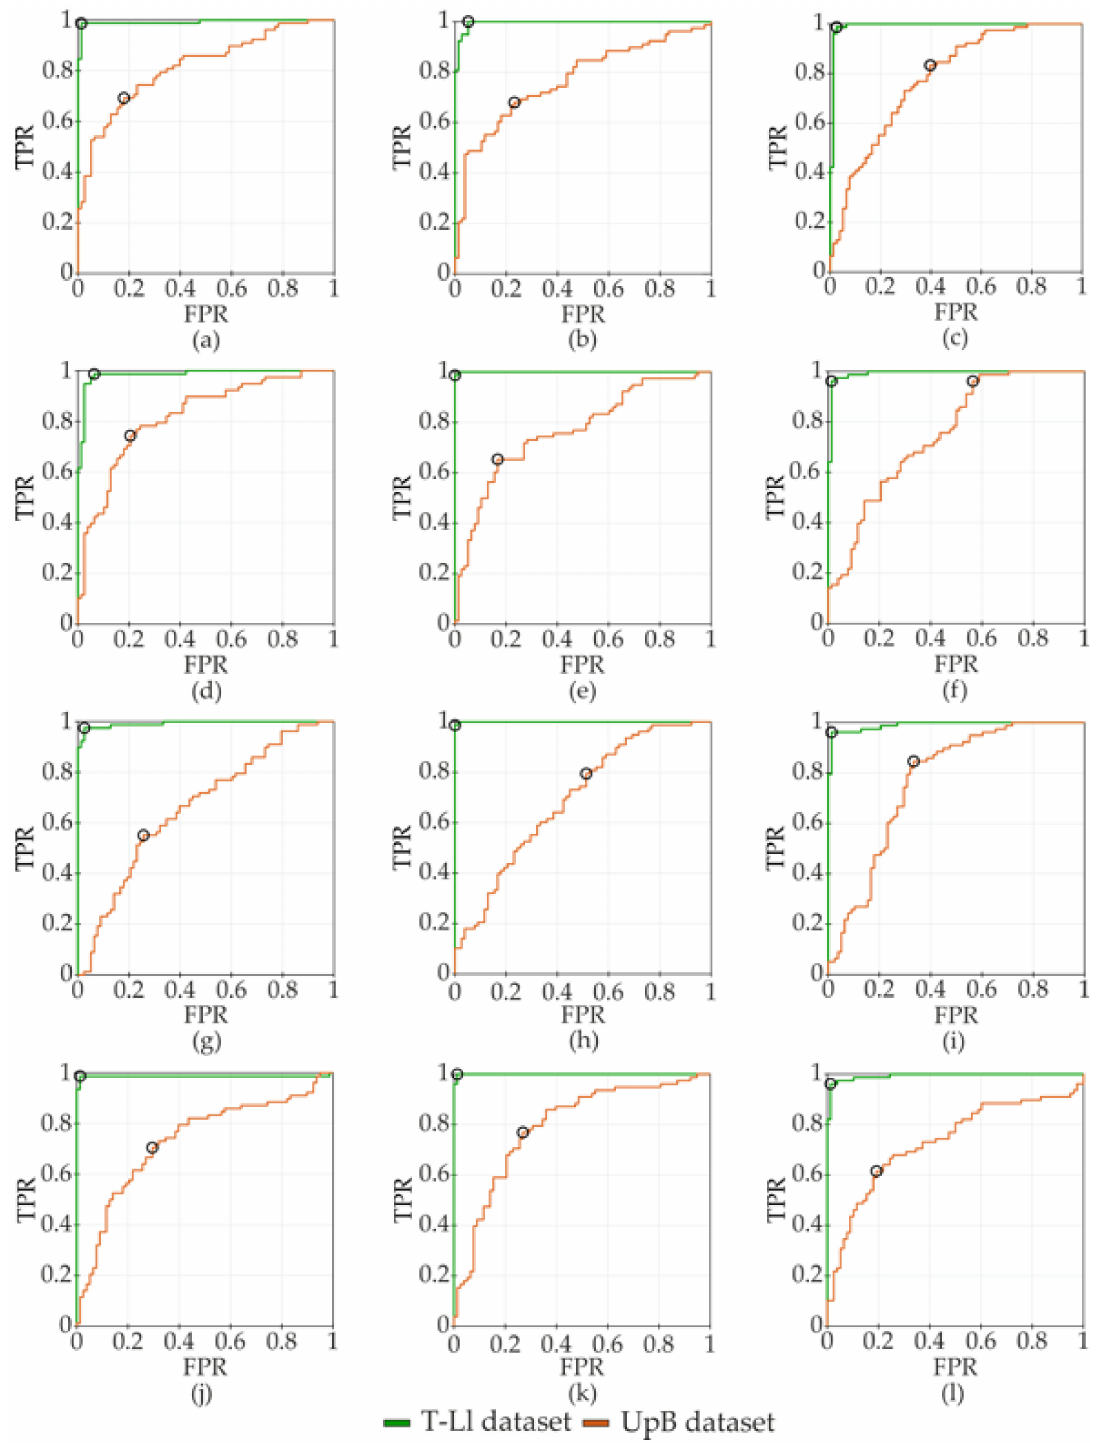
Figure 5. Receiver operating characteristic (ROC) curves of the TL-l dataset and the UpB dataset of the LL task with: linear kernel 1 kg ( a ), 2kg ( b ), and 5 kg ( c ) loads; quadratic kernel 1 kg ( d ), 2 kg ( e ), and 5 kg ( f ) loads; cubic kernel 1 kg ( g ), 2 kg ( h ), and 5 kg ( i ) loads; and Gaussian kernel 1 kg ( j ), 2 kg ( k ) and 5 kg ( l ) loads. The black circle represents the optimal ROC operating